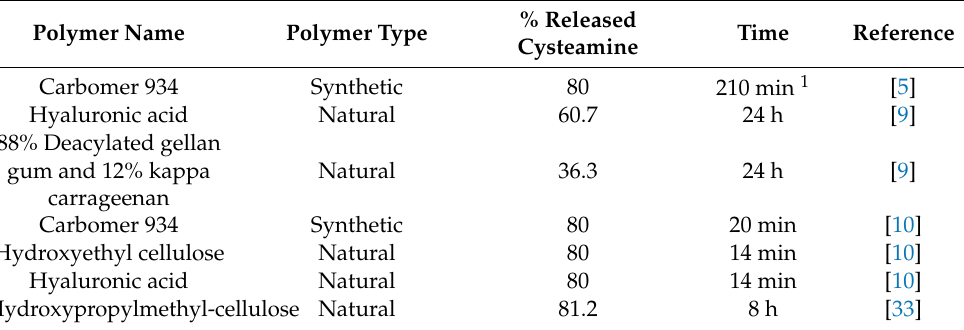
Table 1. Hydrogels developed as cysteamine delivery